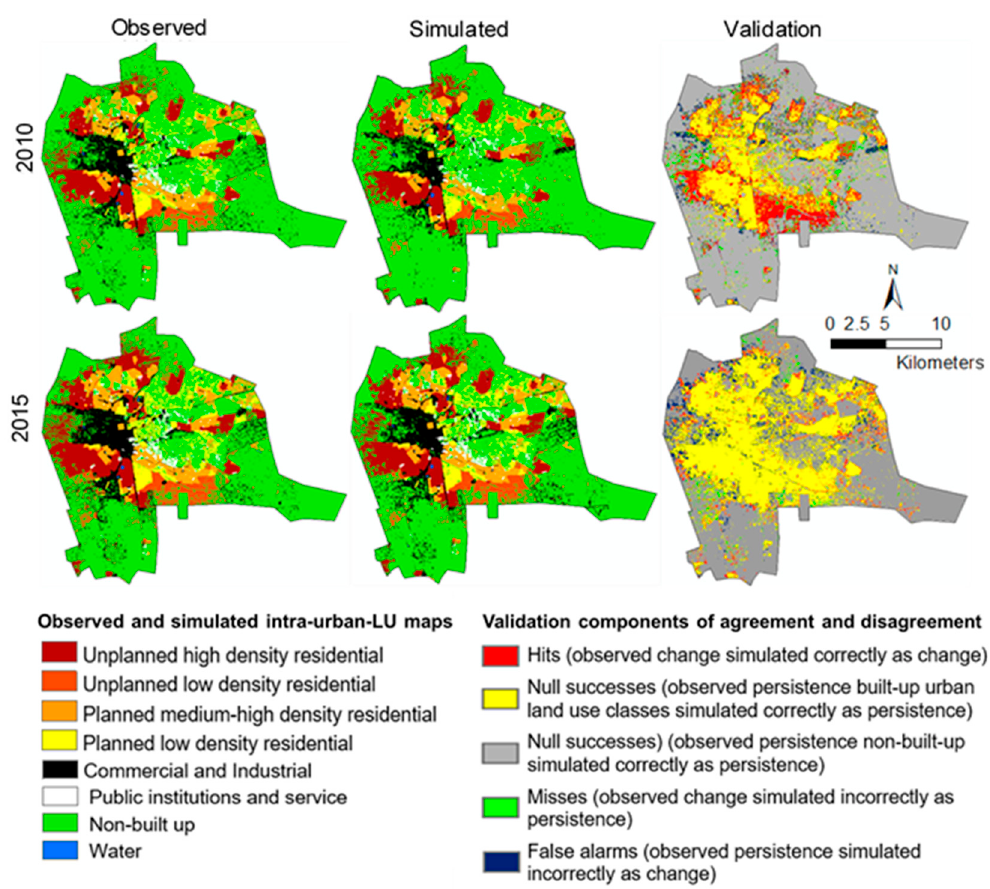
Figure 5. Observed and simulated intra-urban-LU maps for Lusaka city, Zambia, for 2010 and 2015 and their validation components of agreement and disagreement.